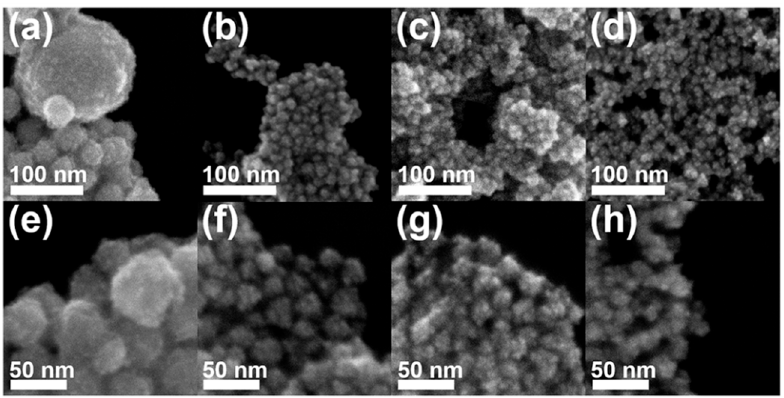
Figure 6. SEM images of Au–Pt NCs produced by ( a , e ) 10 µ L, ( b , f ) 0.2 mL, ( c , g ) 2.0 mL, and ( d , h ) 5.0 mL of hydrazine (200 mM).